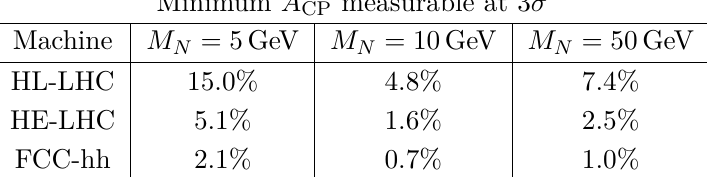
Table 2 . Minimum value of A CP measurable at 3 σ at the HL-LHC ( √ 3 ab − 1 ), HE-LHC ( s = 27 TeV, peak L int = 15 ab − 1 ), and FCC-hh ( 30 ab − 1 ). Results are given for M N = 5 GeV (reduction factor = 0 . 1 ), M N = 10 GeV (no